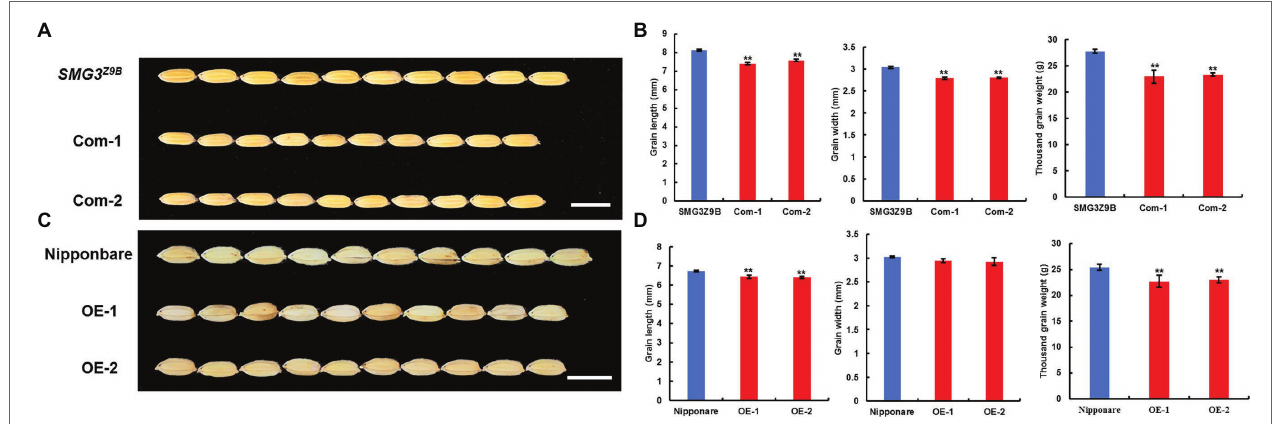
FIGURE 2 | Complementary test and overexpression analysis. (A) Grains of NIL- SMG3 Z9B and complementary (Com) transgenic plants. Scale bar: 8 mm. (B) Grain length, grain width, and thousand grain weight of NIL- SMG3 Z9B and the complementary transgenic lines. (C) Grains of Nipponbare and overexpression (OE) transgenic plants. Scale bar: 8 mm. (D) Grain length, grain width, and thousand grain weight of Nipponbare and the SMG3 overexpression transgenic lines. Data in (B) and (D) are the means ± SD; ** indicates p < 0.01 by Student’s t